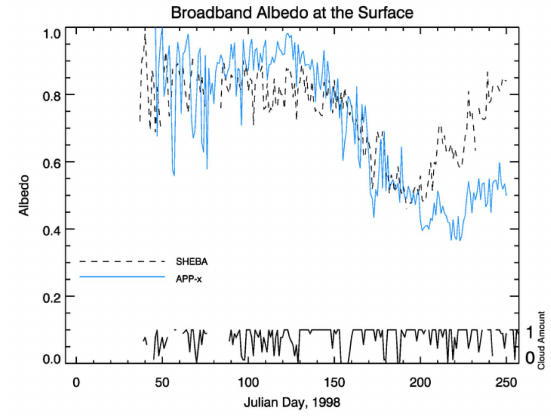
Figure 8. Comparison of satellite-derived and surface measurements of the surface broadband albedo during SHEBA. Cloud amount is also shown.